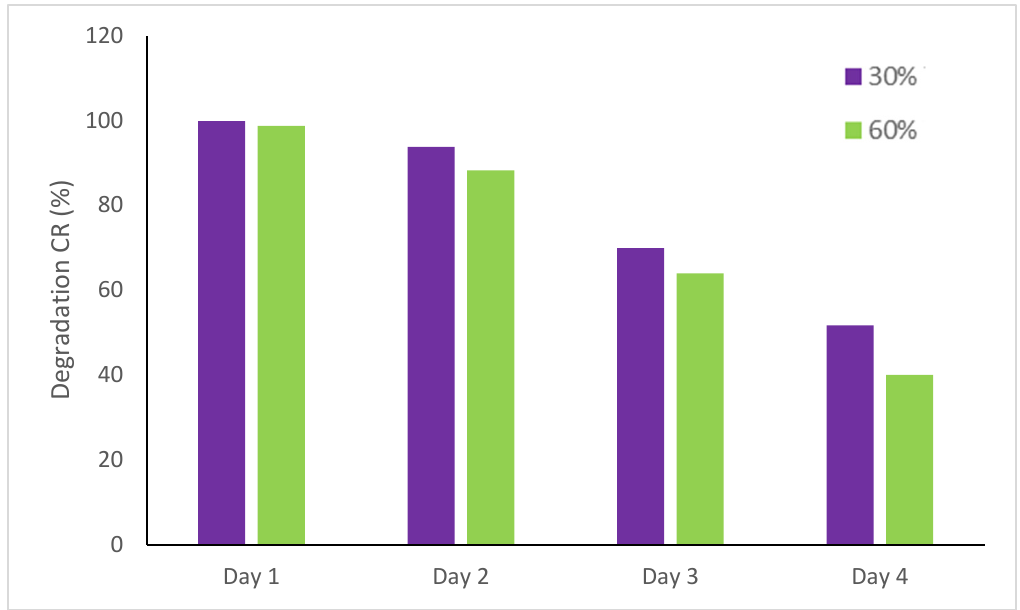
Figure 7. Reusability of 30% and 60% TiO 2 –JK NC for catalytic degradation after 4 h of solar irradi ‐ ation.